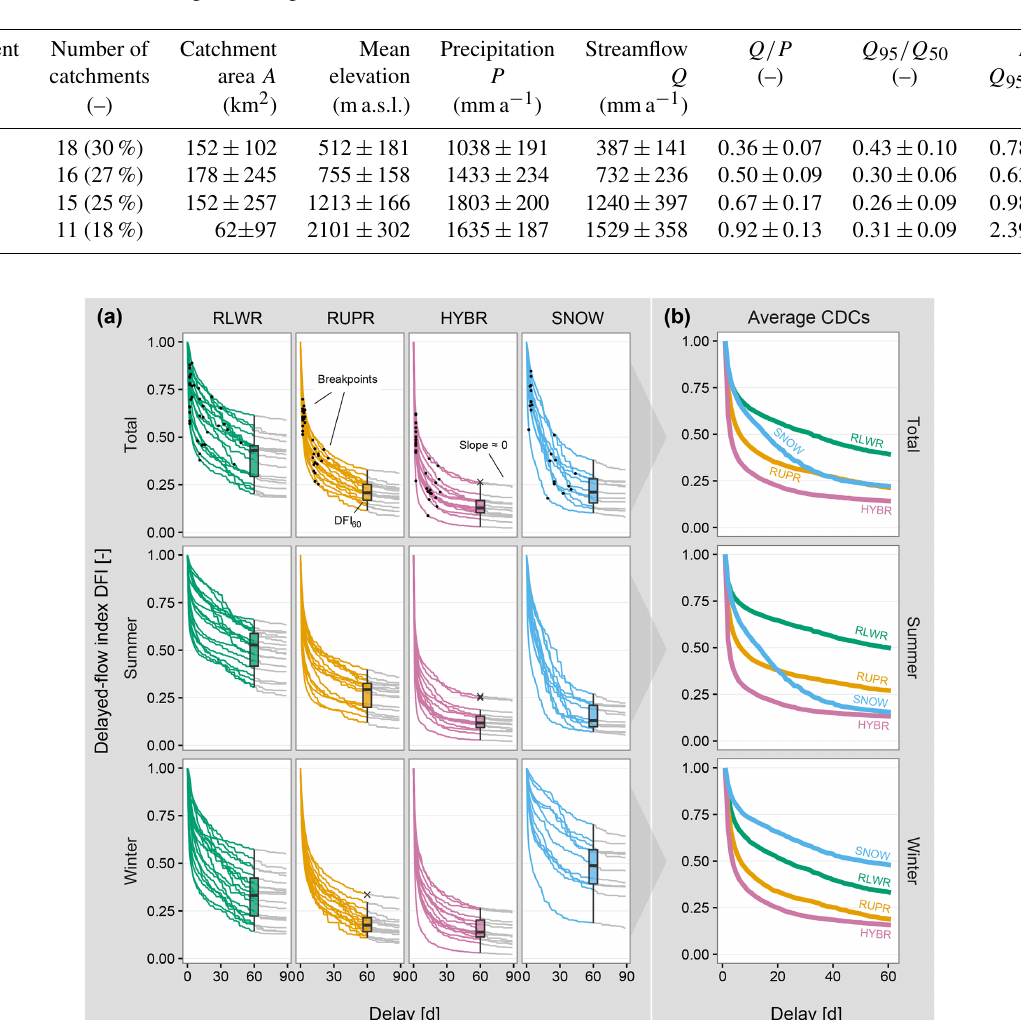
Table 2. Catchment characteristics and hydrometeorological metrics (based on the period 1992–2013) of the four catchment groups. Numbers given are the average values with the standard deviation of catchments within each group. The seasonality ratio R S is the ratio of standardized summer low flows ( Q 95s during May–October) and winter low flows ( Q 95w during November–April). More details on catchment, climate and streamflow characteristics are given in Fig. A1.